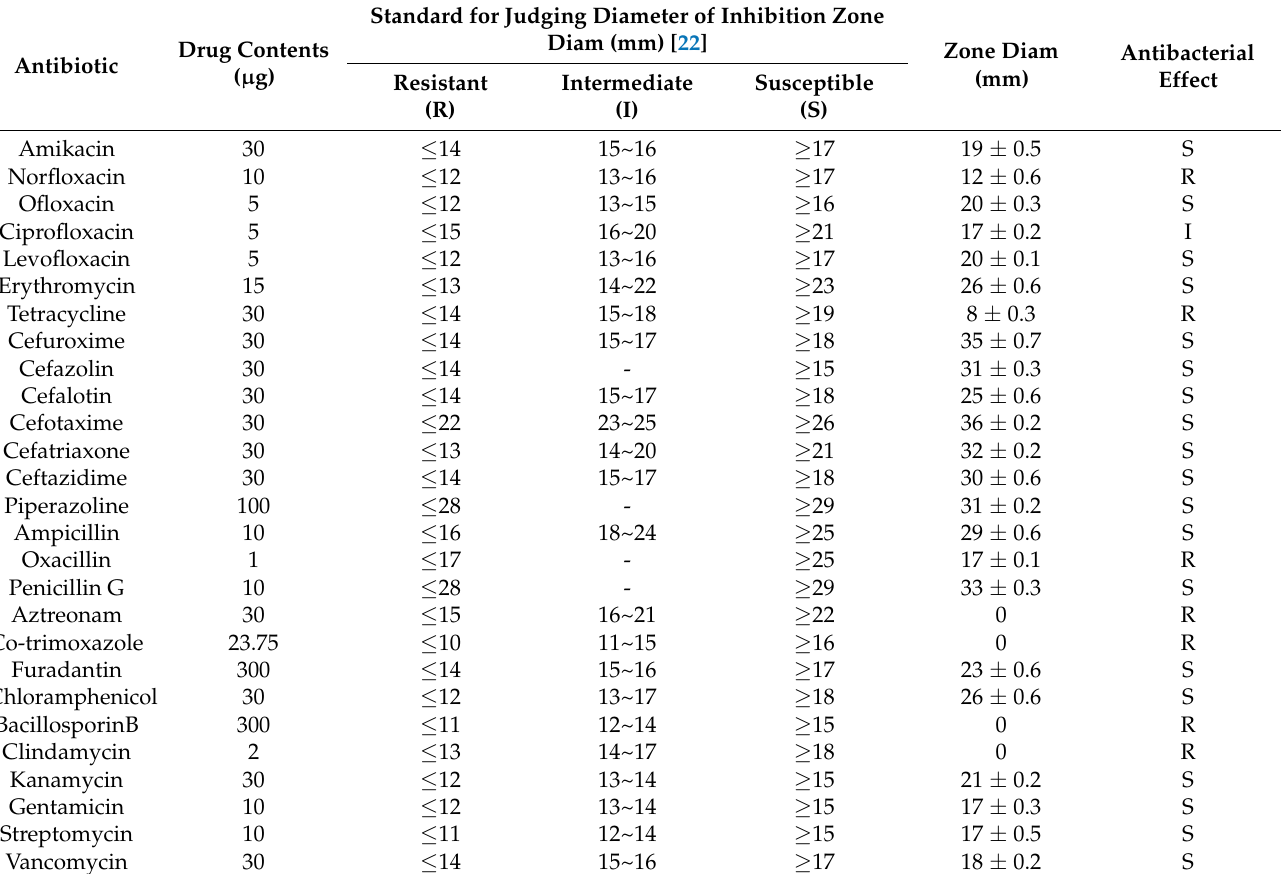
Table 1. Drug sensitivity test results of Lactococcus garvieae FUA009 to 27 antibiotics.